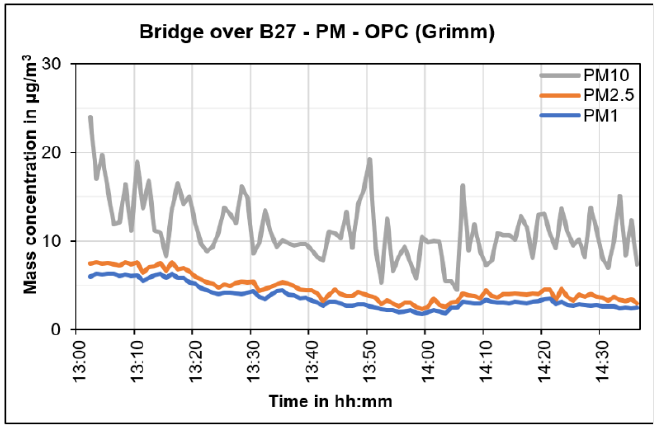
Figure 26. Freeway measurement results for PM1, PM2.5, and PM10.